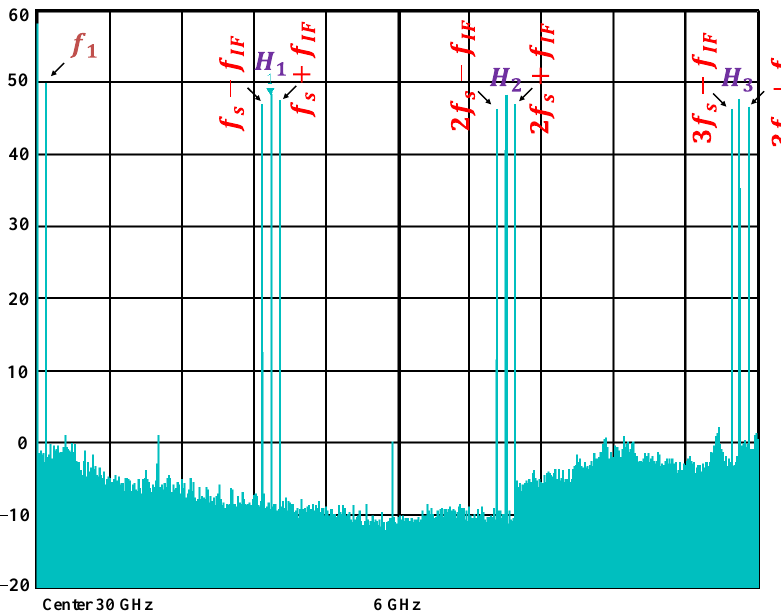
Figure 5. Experimental electrical spectrum of the signal to be up-converted at 𝑛𝑓 𝑠 ± 𝑓 𝐼𝐹 at the outer port of the SOA – MZI.